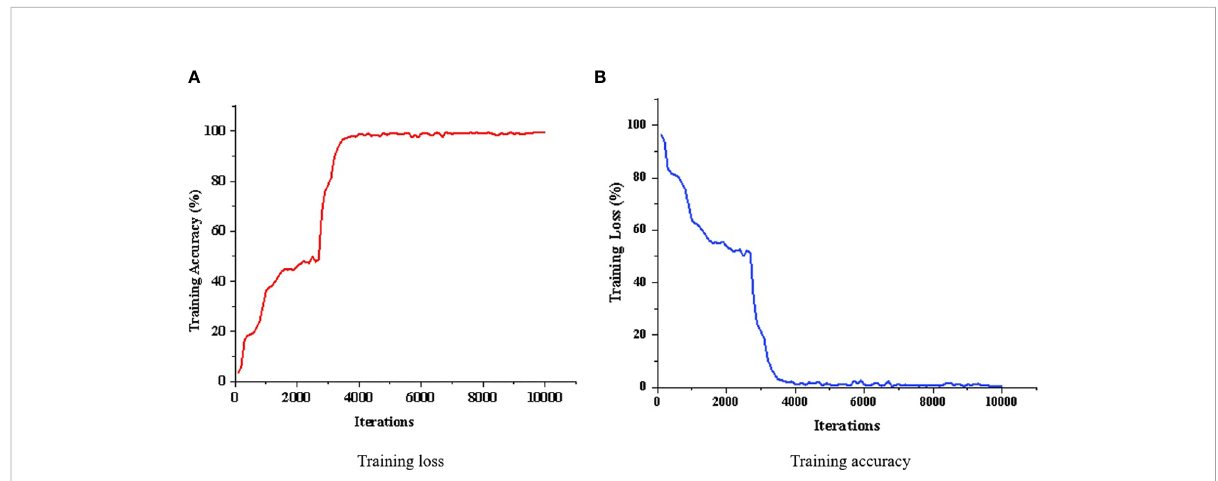
FIGURE 6 Training results. (A) Training loss. (B) Training